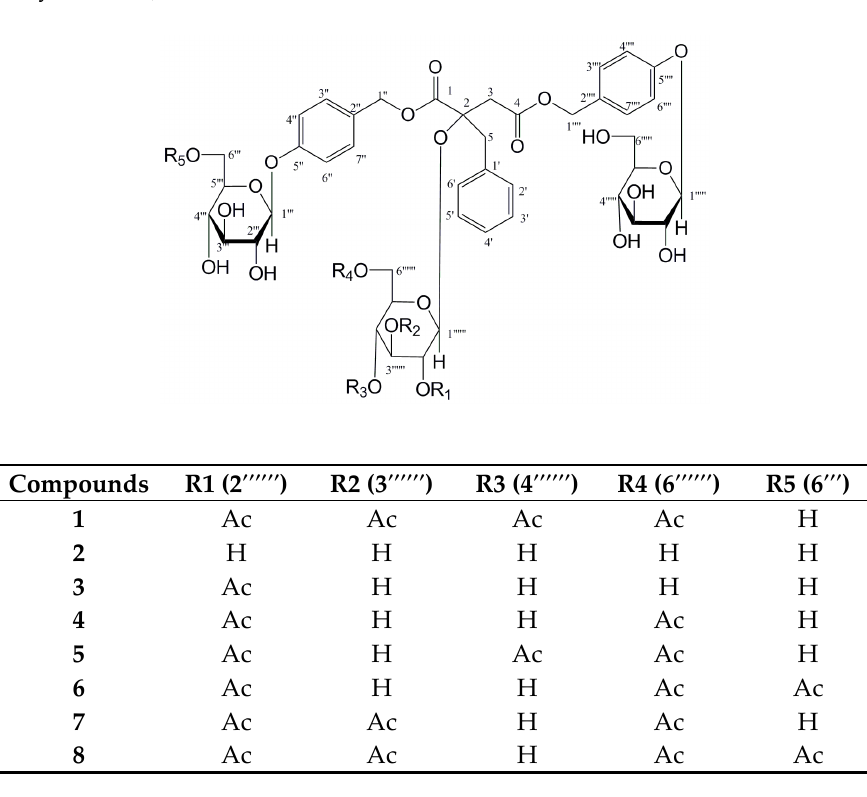
Figure 1. Structures of compounds 1 ~ 8.